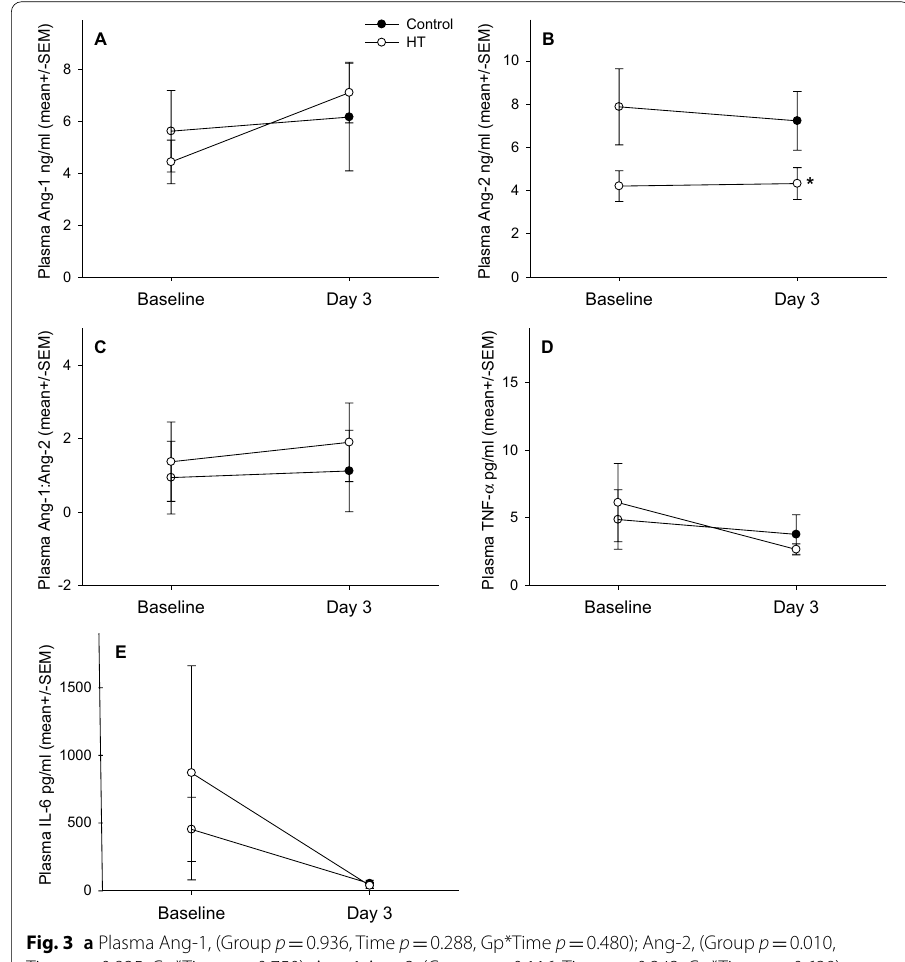
Fig. 3 a Plasma Ang-1, (Group p Time p 0.825, Gp*Time p = IL-6 (Group p 0.634, Time p = Gp*Time